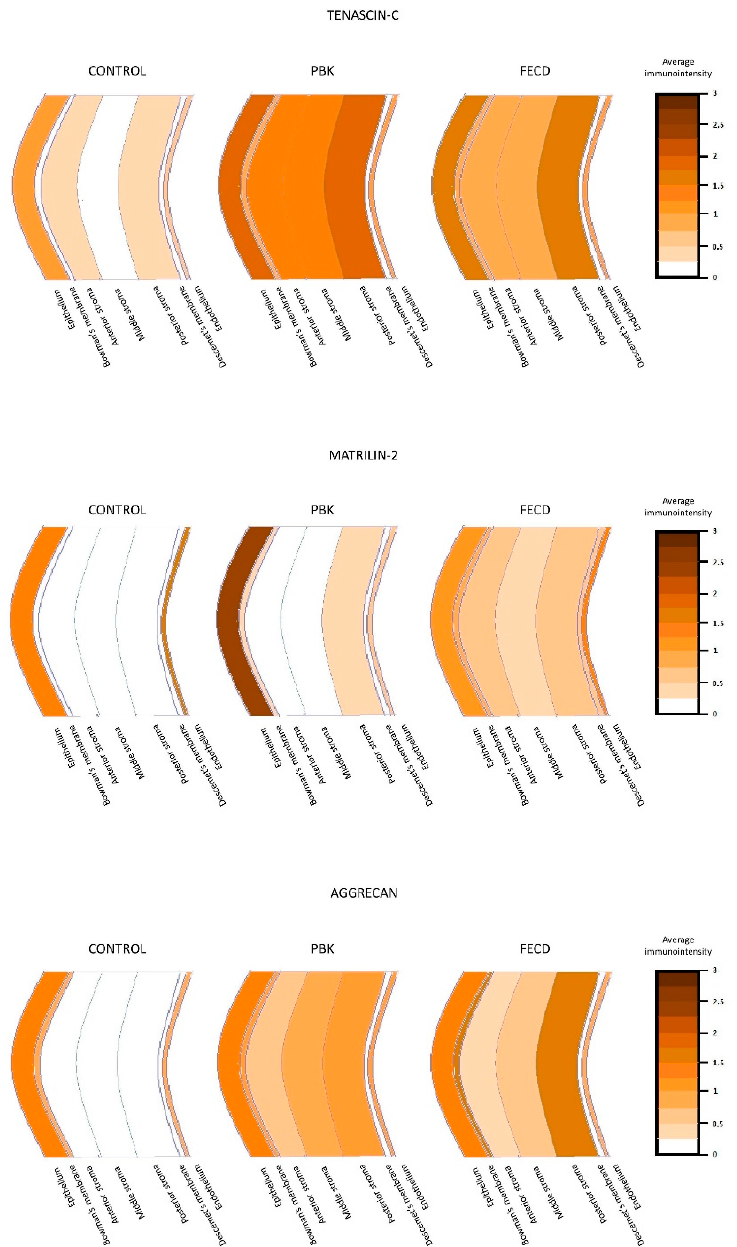
Figure 7. The average immunointensity of tenascin-C, matrilin-2 and aggrecan in normal controls, PBK and FECD groups. PBK = pseudophakic bullous keratopathy, FECD = Fuchs’ endothelial corneal dystrophy. Scale bar and colour mark indicates the average immunointensity of the investigated ECM proteins.